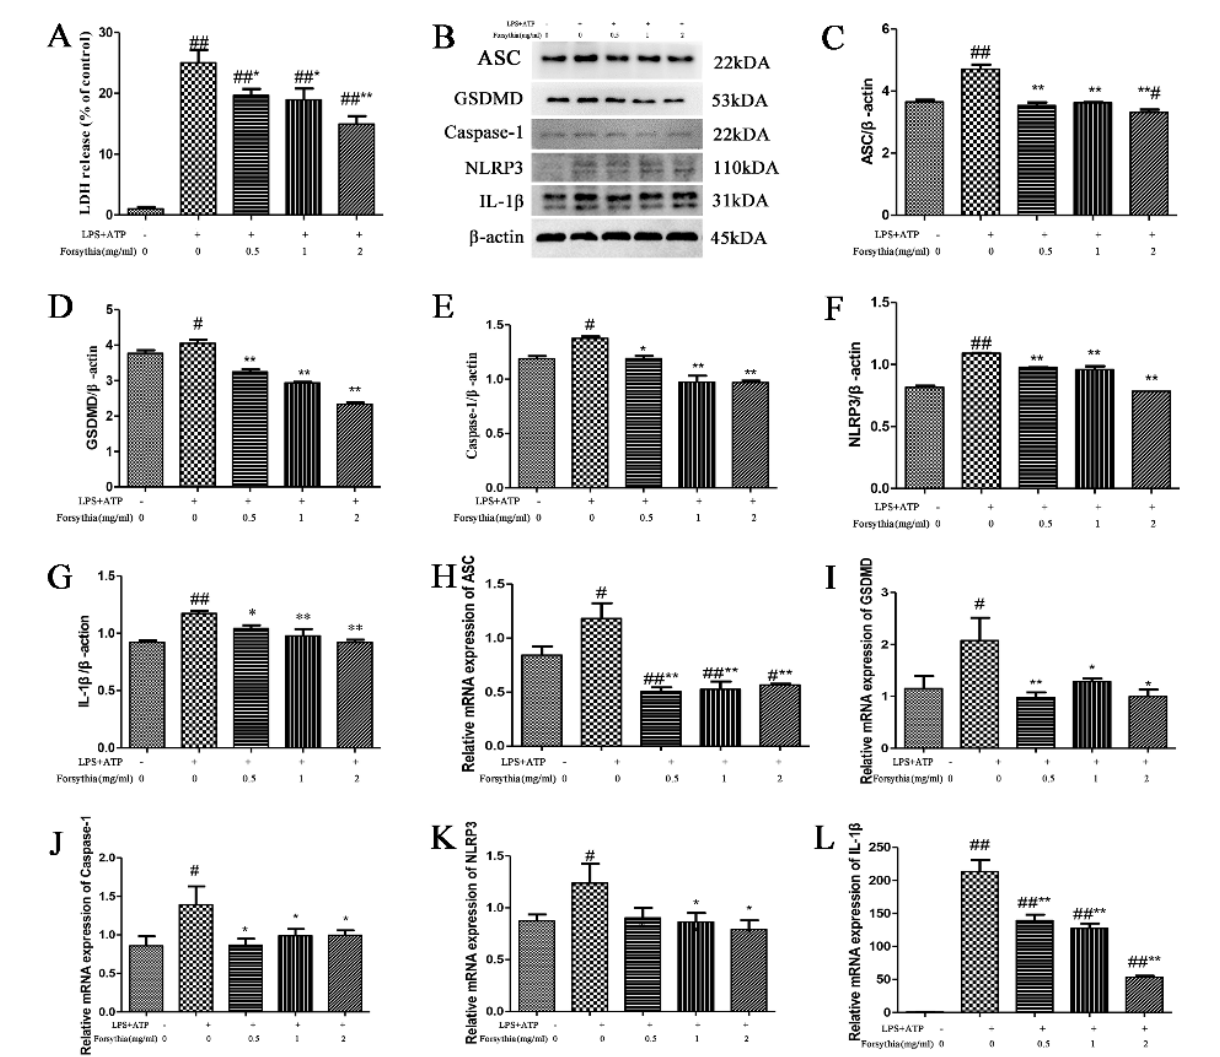
Figure 5. Forsythia suspensa extract can reduce the protein and gene expression of pyroptosis in J774A.1 cells. ( A ) J774A.1 cells were first treated with 1 µ g/mL LPS and different concentrations of Forsythia suspensa extract for 12 h, and then stimulated with 5 mM ATP for 1 h. The kit detects the level of LDH release. ( B – G ) Western blot analysis of ASC, Caspase-1, IL-1 β , GSDMD and NLRP3. ( H – L ) qRT–PCR detection of ASC , Caspase-1 , IL-1 β , GSDMD and NLRP3 gene expression levels. Data represent at least three independent experiments. The results are shown as the mean ± SEM. # p < 0.05, and ## p < 0.01 compared with the control group; * p < 0.05, and ** p < 0.01 compared with the model group; #** means # and **; ##** means ## and **.